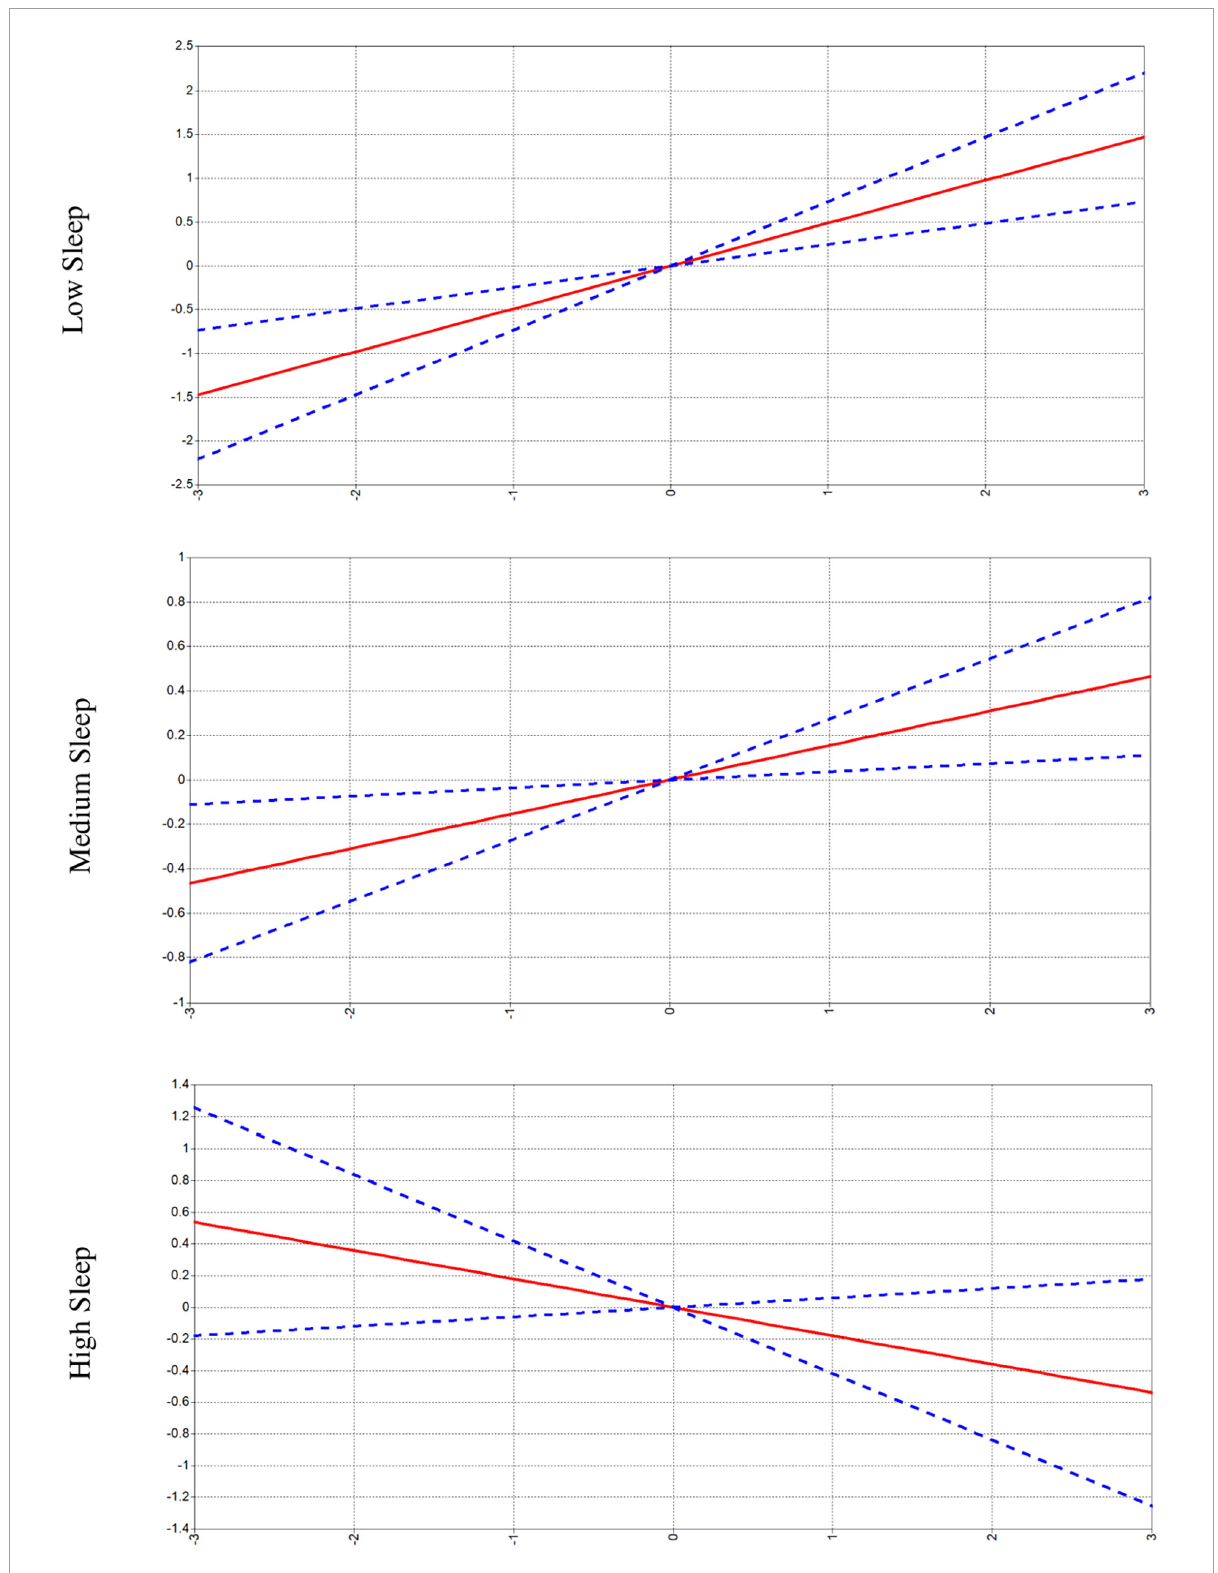
FIGURE4 Effects of physical activity (PA) on Tower of London extra moves scores moderated by sleep. Blue dotted line is the 95% confidence interval and red line is the trend line of the means. The X axis for all three figures is PA, and the Y axis is Tower of London extra